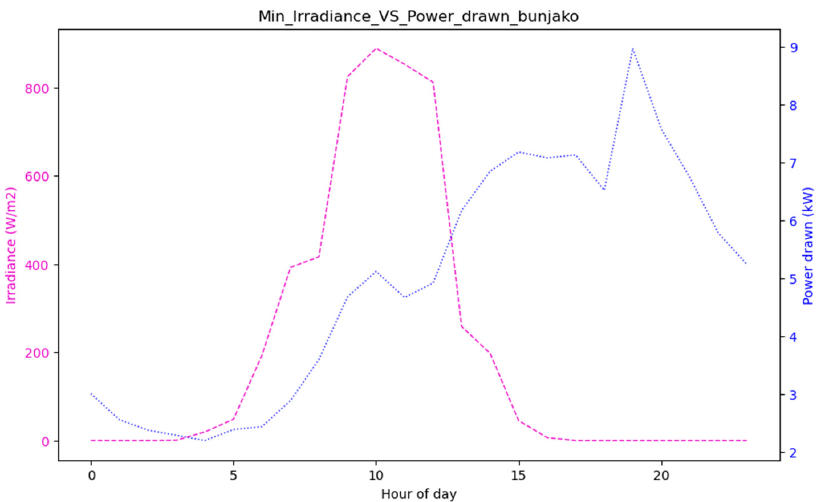
Figure 15. Comparisons between average hourly power consumed (in kW) and minimum daily irradiance (in W/m 2 ) measured at Bunjako (22–28 February 2022).